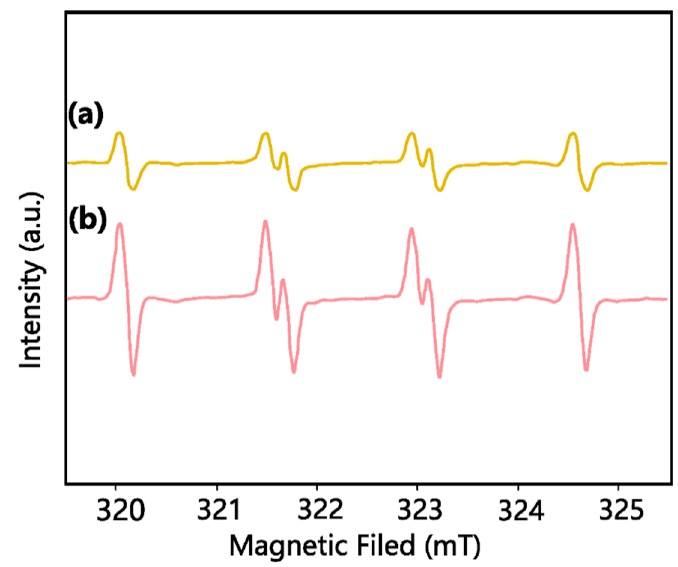
Figure 6. Electron paramagnetic resonance (EPR) spectra for the (a) UV/S(IV) and (b) UV/S(IV)/BiOI systems after reaction for 2 min. Conditions: [BiOI] 0 = 1.0 g ⋅ L − 1 (84.9 μ M as I); [S(IV)] 0 = 1.0 mM; [MCAA] 0 = 10 μ M; [DMPO] 0 = 0.1mM; [DO] 0 = 0.22 mM (7.1mg ⋅ L − 1 ); pH = 7.0, 25 ± 1 °C.